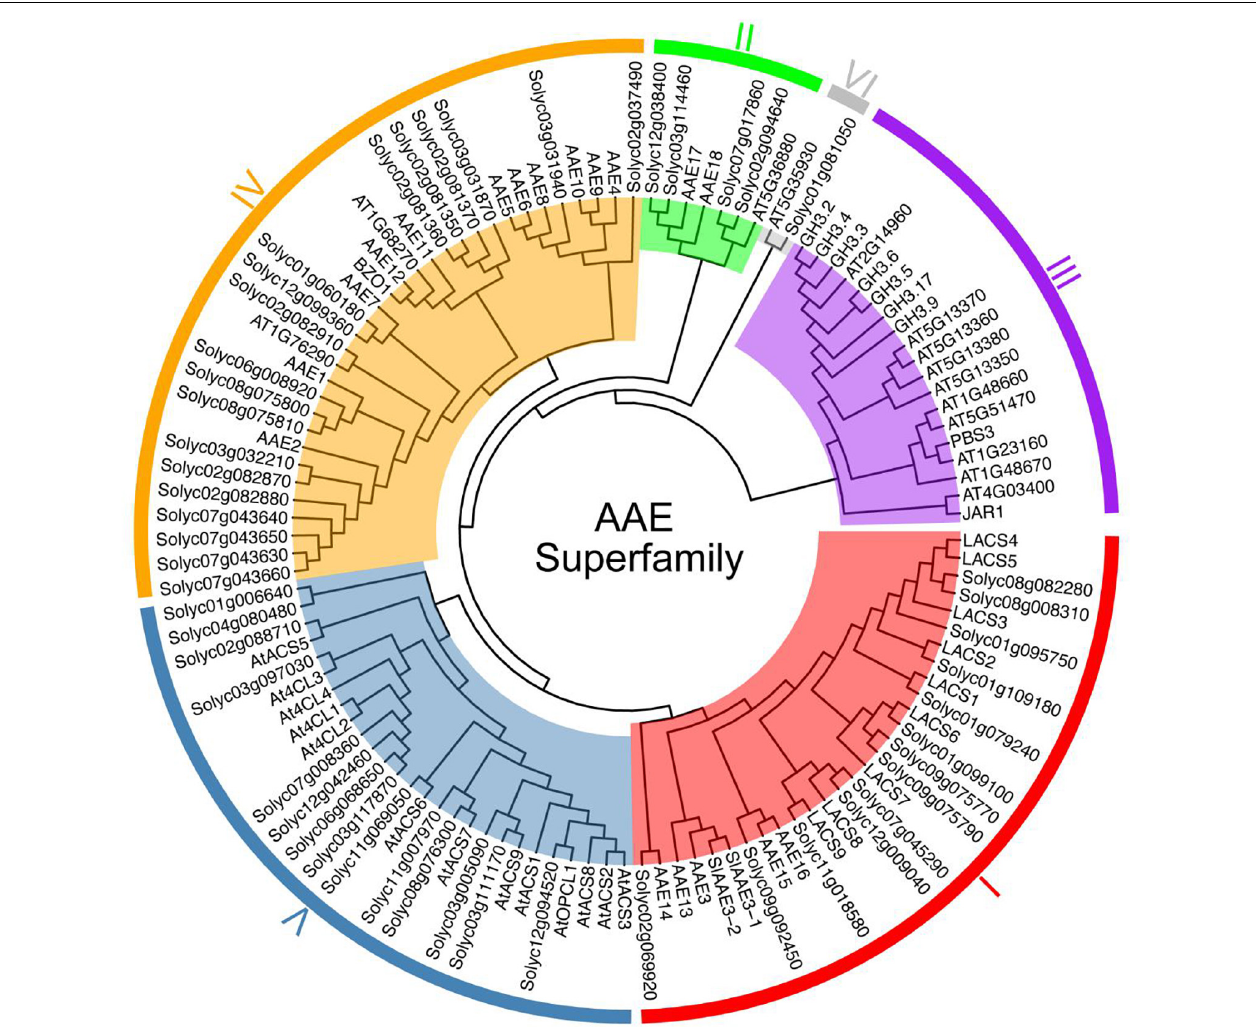
FIGURE 1 | The phylogenetic analysis of tomato ( S. lycopersicum ) acyl-activating enzymes (AAEs) (SlAAEs). The phylogenetic analysis of AAEs from tomato and Arabidopsis using the complete protein sequences. The neighbor-joining (NJ) tree was constructed using the MEGA 7.0 software with the pairwise deletion option, and 1,000 bootstrap replicates were used to assess tree reliability. AAEs from tomato and Arabidopsis fell in six separate subfamilies as I–VI.